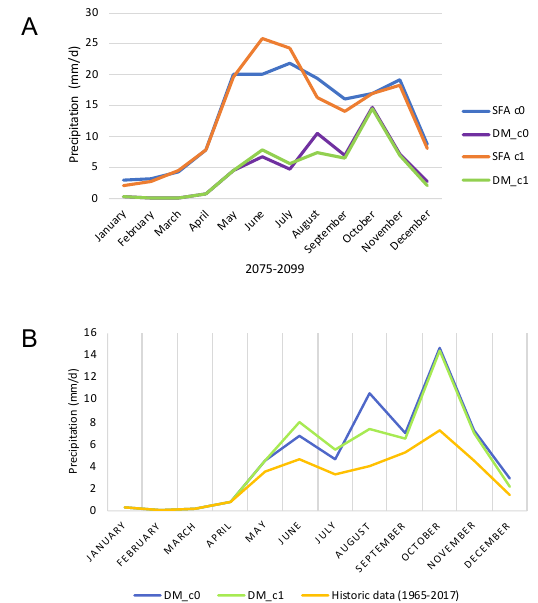
Figure 6. Comparison of monthly averages of daily precipitation for data projected by the model (RCP8.5 trajectory and C0 and C1 SST schemes) and the respective data corrected using Delta Method ( A ). Comparison of the corrected precipitation values with the historical averages ( B